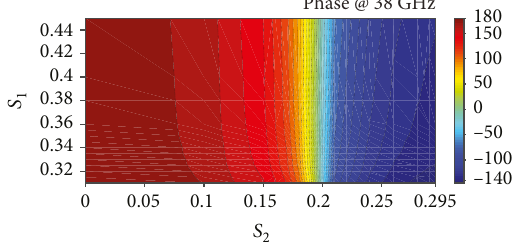
S 1 and 2 (at 28 GHz).